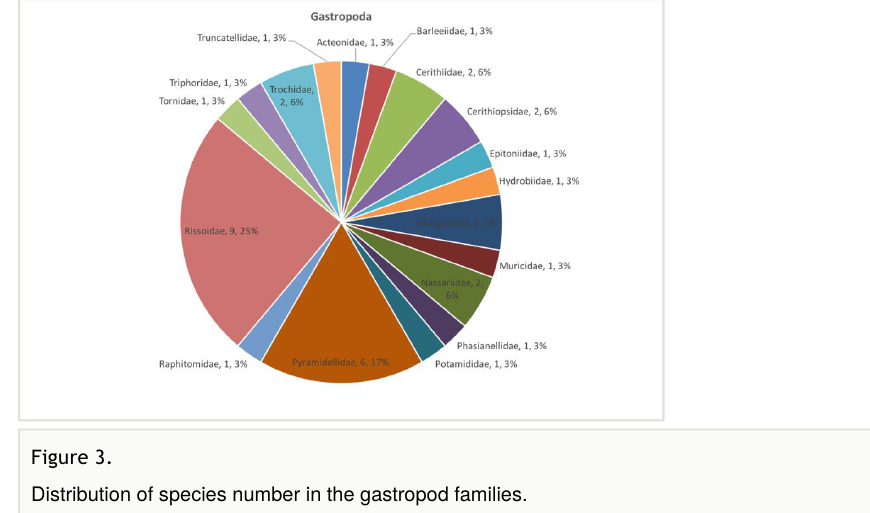
Figure 3. Distribution of species number in the gastropod